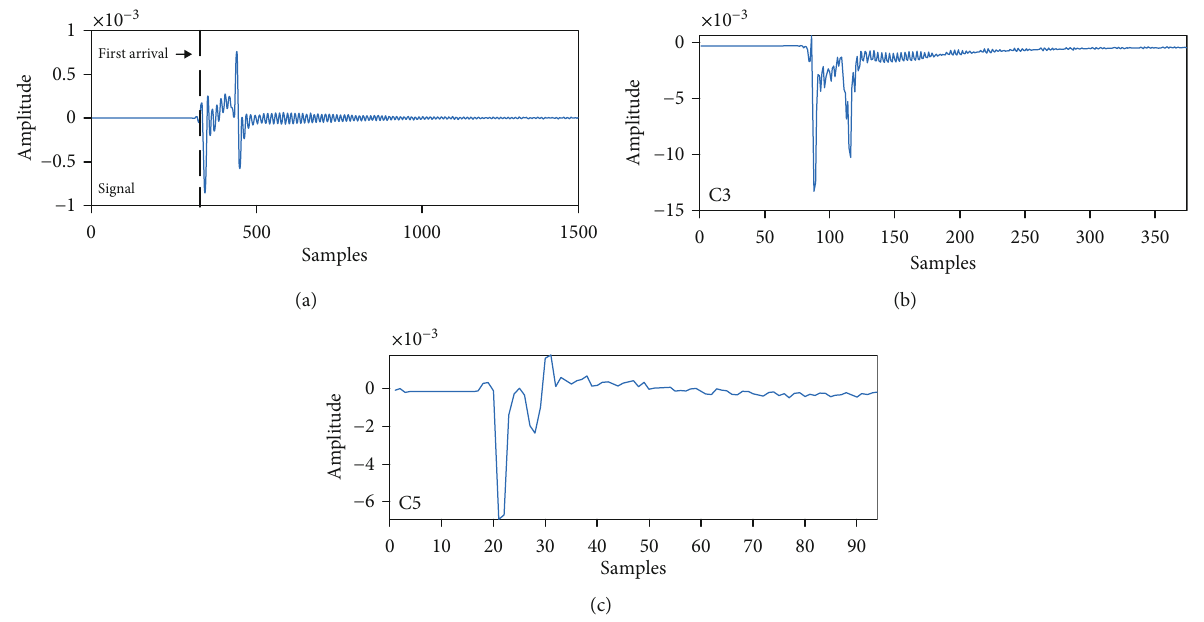
Figure 8: Noise-free forward modeling signal and its intermediate features extracted by the UNet++. (a) The noise-free forward modeling signal. (b) Intermediate features of the signal extracted by C3 layer. (c) Intermediate features of the signal extracted by C5